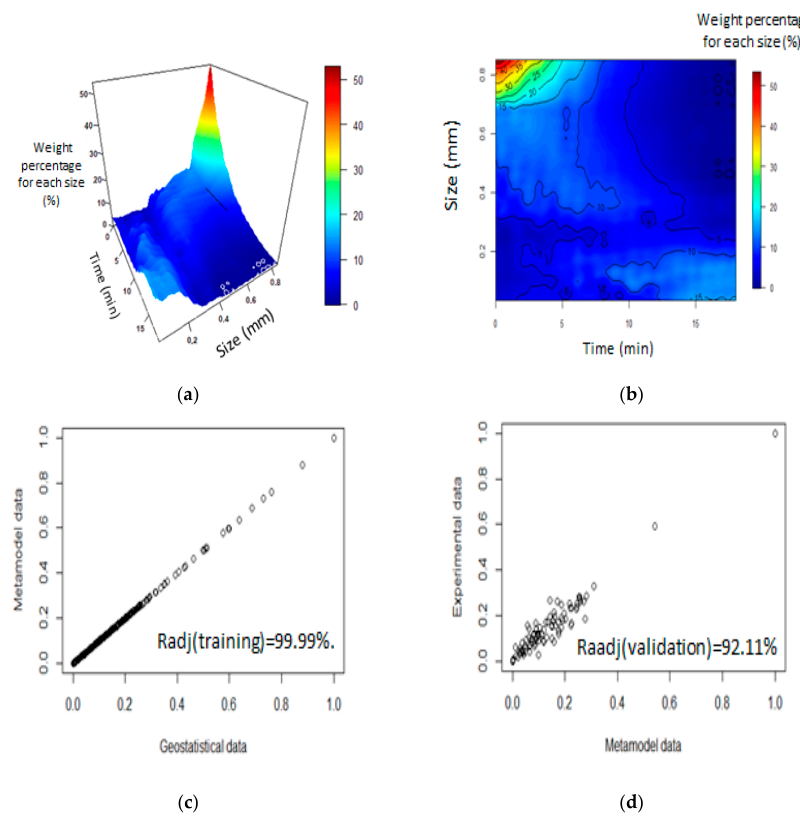
Figure 11. Results obtained for LGP-1 for ore-A. ( a ) Spatial trend with normalized data. ( b ) Contours graphic. ( c ) Cross-analysis with the meta-model data and geostatistical data. ( d ) Cross-analysis with the experimental data and meta-model